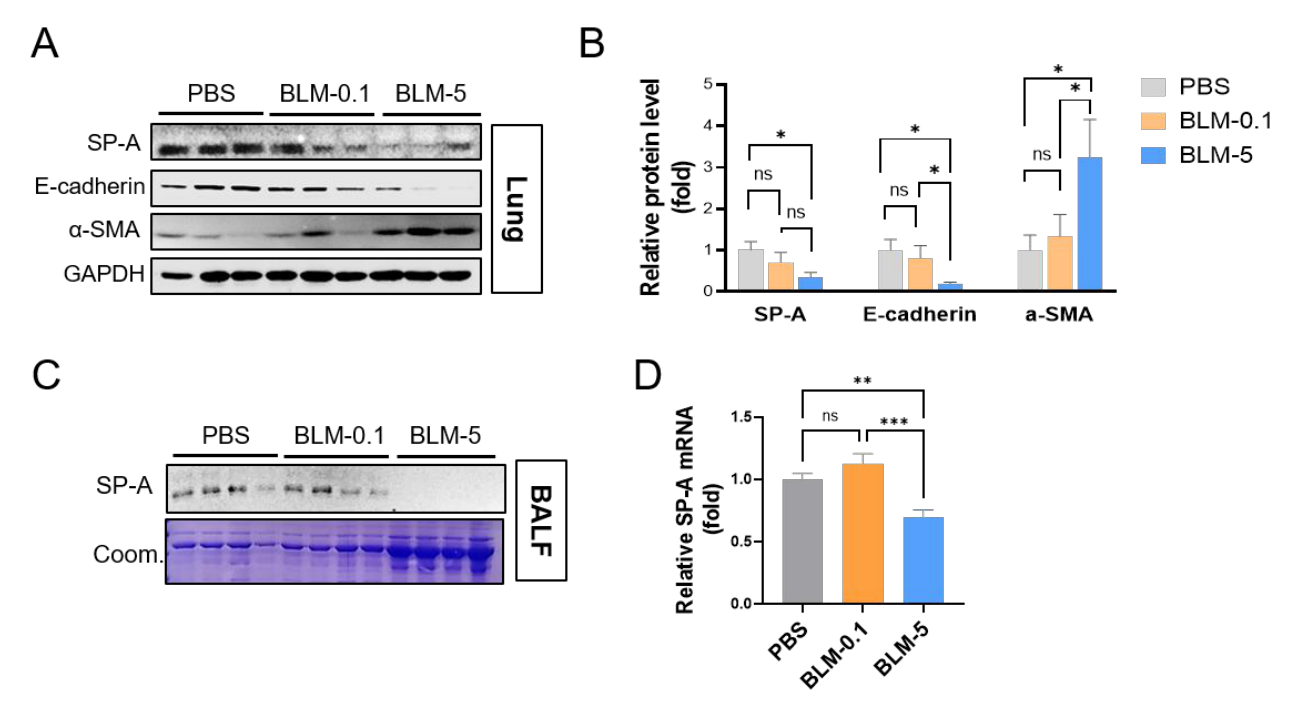
Figure 1. SP-A expression inversely correlates with the severity of pulmonary fibrosis in mice induced with bleomycin. ( A – C ) Western blot images showing the expression of SP-A in lung tissues ( A , B ) and BAL fluid ( C ) from mice induced with BLM. The relative protein level of E-cadherin or α -SMA normalized to GAPDH was calculated as fold change compared to those in PBS-treated group. Coom. indicates Coomassie staining as loading control. ( D ) Quantitative real-time qPCR analysis of SP-A was used to measure the mRNA levels in the lung tissues in each group. n = 5–9 per group. The data are presented as the mean ± SE. * p < 0.05, ** p < 0.01, *** p < 0.001. ns indicates no significant difference between groups.